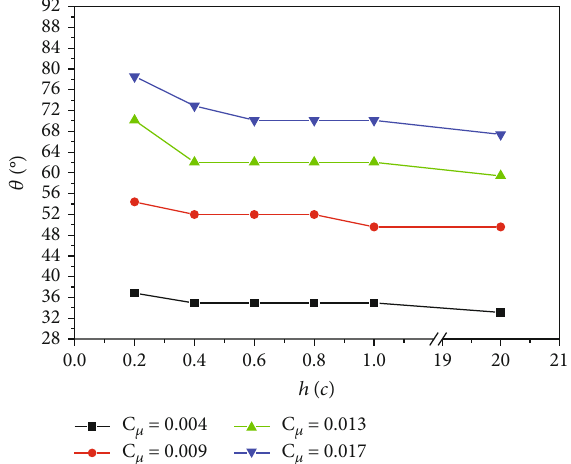
Figure 29: Curves of separation angle versus ride height for the airfoil with upper slot blowing at α = 4 °